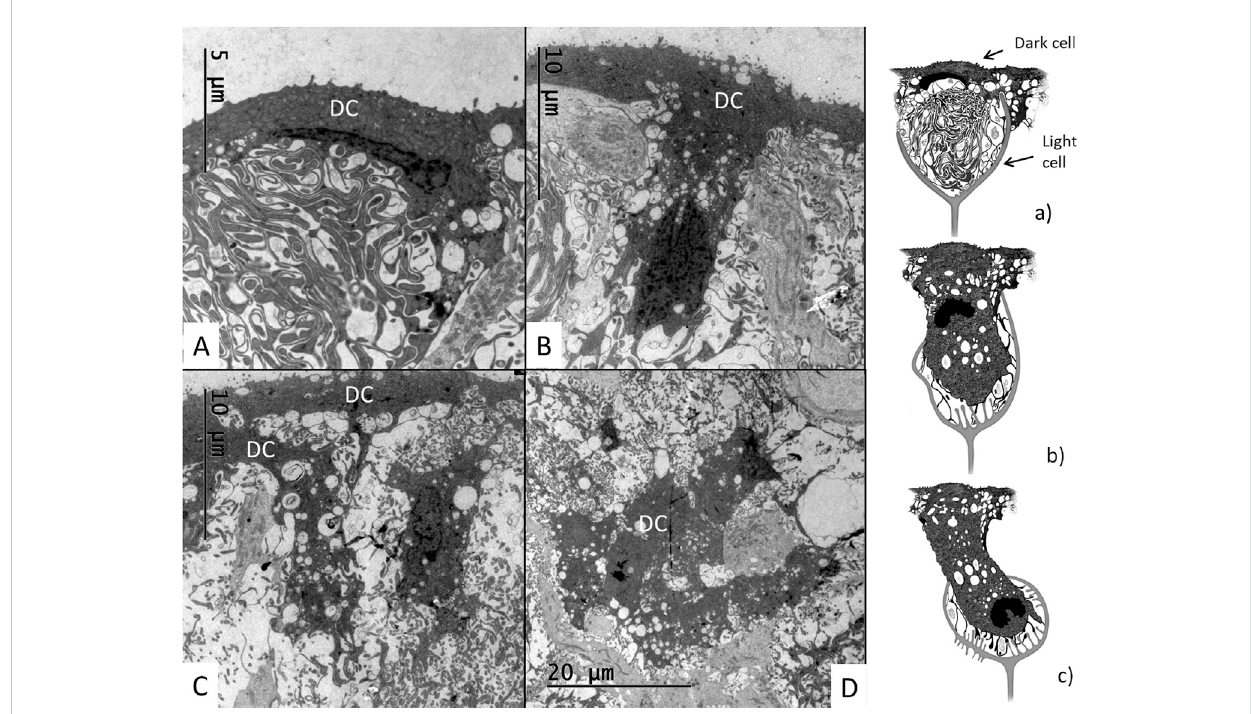
FIGURE 12 ElectronmicroscopyshowingdifferentanatomyofthedarkcellsinthecrocodilianSV. (A) Adarkcellswiththinapicalcytoplasm andextensivebasal lamellae. (B) A T-shaped elongated dark cell projects into theepithelium. Itscell nucleus headsthebasal front. (C) A dark cell (left)elongatesanddeviates basally.Itcontainsalargenumberofclearvesiclesandvacuolesassumedtorepresentsecretoryvesicles. (D) Aconglomerateofdarkcellsaresurrounded by light cells. (a – c) Illustration of different dark and light cells morphology in the crocodilian